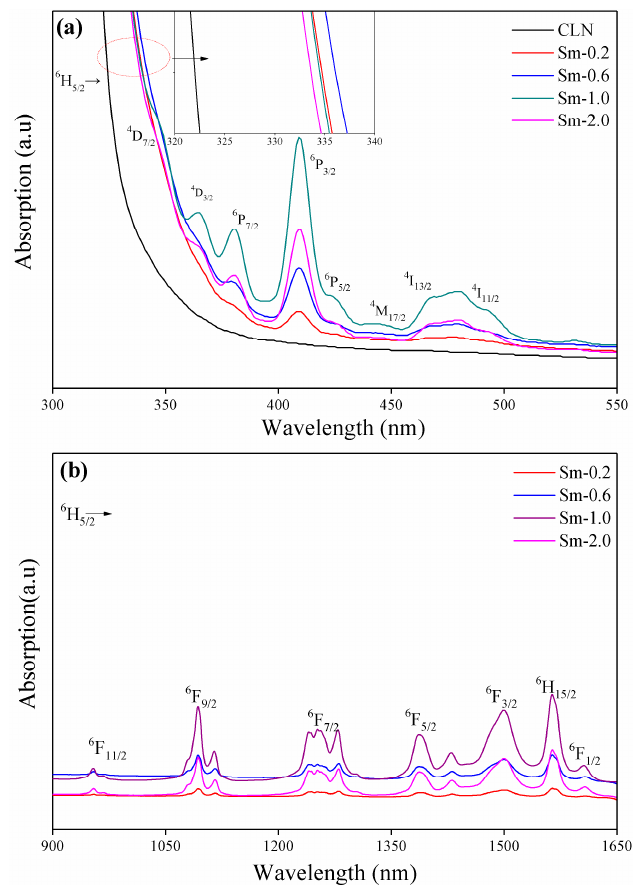
Figure 3. ( a )UV–vis absorption spectra of Sm:LN single crystals. ( b ) Near-infrared absorption spectra of the Sm:LN single crystals.